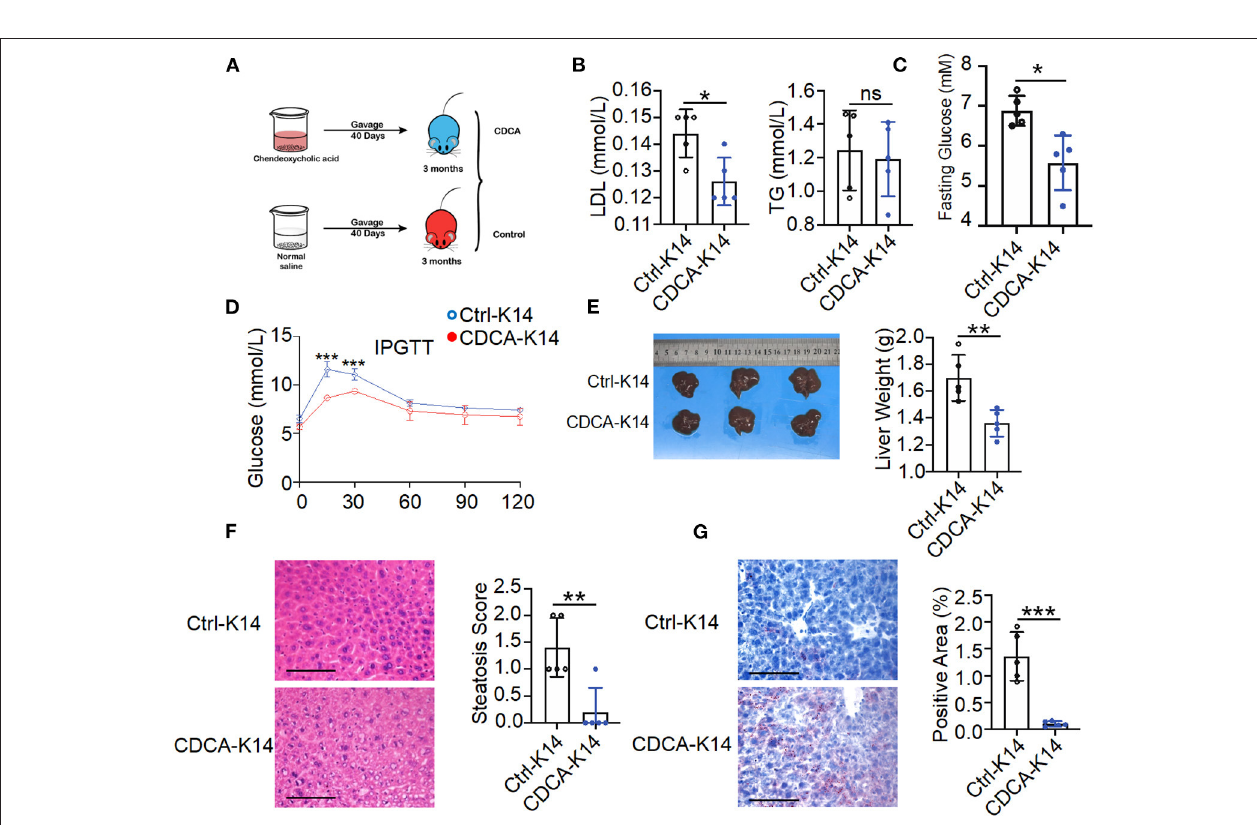
FIGURE 6 | Supplement with CDCA improved metabolic status of K14-VEGF mice. (A) Experimental design diagram. Three-month-old K14-VEGF mice ( n = 5) were gavaged with CDCA (10 mg/kg) as the CDCA-K14 group. Another group was gavaged with solvent as K14-control group. All mice were gavaged for 40 days. (B) Serum LDL and TG level. (C) Fasting blood glucose levels. (D) Blood glucose concentrations following intraperitoneal glucose tolerance tests. (E) Representative pictures and weight of livers. (F) Representative HandE-stained sections of liver and degrees of hepatic steatosis. Scale bar, 100 µ m. (G) Representative images of liver tissues Oil Red staining and quantification of hepatic ORO. Scale bar, 100 µ m. Statistical analysis for (A–G) : Each symbol represents a mouse, and bars represent means and SEM. Statistical tests used were Student’s t -test in (B–G) . * P < 0.05, ** P < 0.01, and *** P <